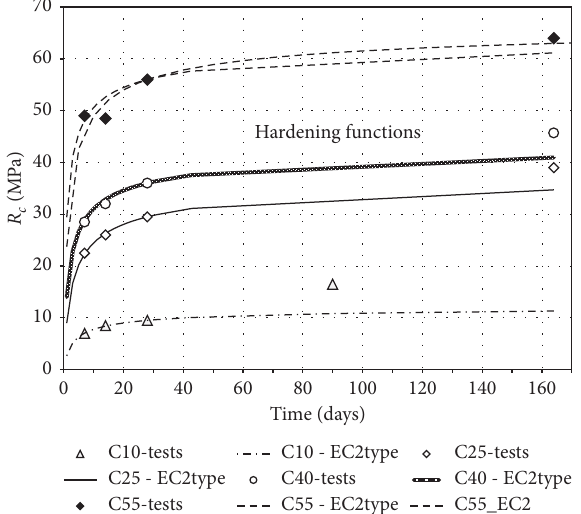
Figure 4: Hardening curves of the concrete